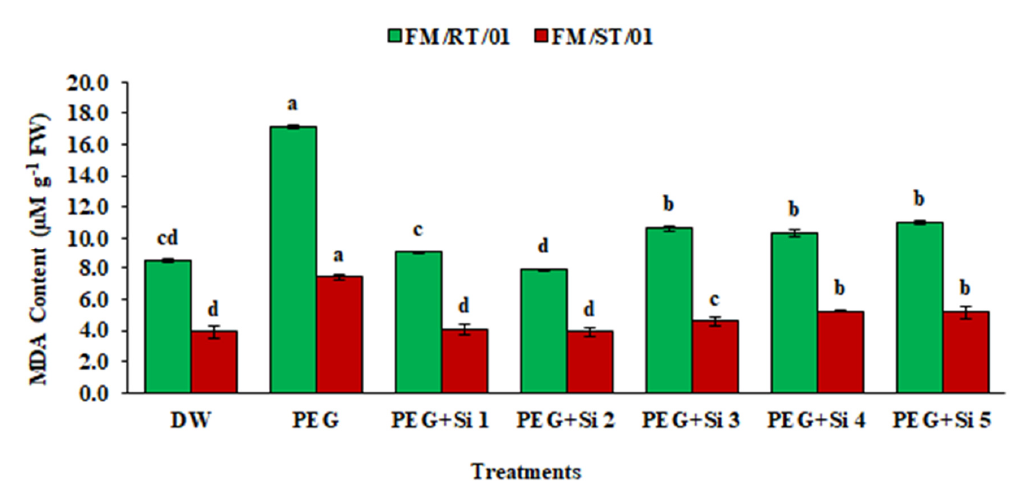
Figure 1. Effect of Si on lipid peroxidation (in terms of MDA content) in seedlings of local finger millet landraces under PEG-6000 induced osmotic stress Values represent mean±SE. Values for each landrace with different alphabets are significantly different at p =0.05 as per Duncan’s Multiple Range Test. Si: Silicon; FM/RT/01: Osmotic stress sensitive landrace; FM/ST/01: Osmotic stress tolerant landrace; DW: Distilled water; PEG: Polyethylene glycol (15%); Si 1: Si 5 ppm; Si 2: Si 10 ppm; Si 3: Si 15 ppm; Si 4: Si 20 ppm and Si 5: Si 25